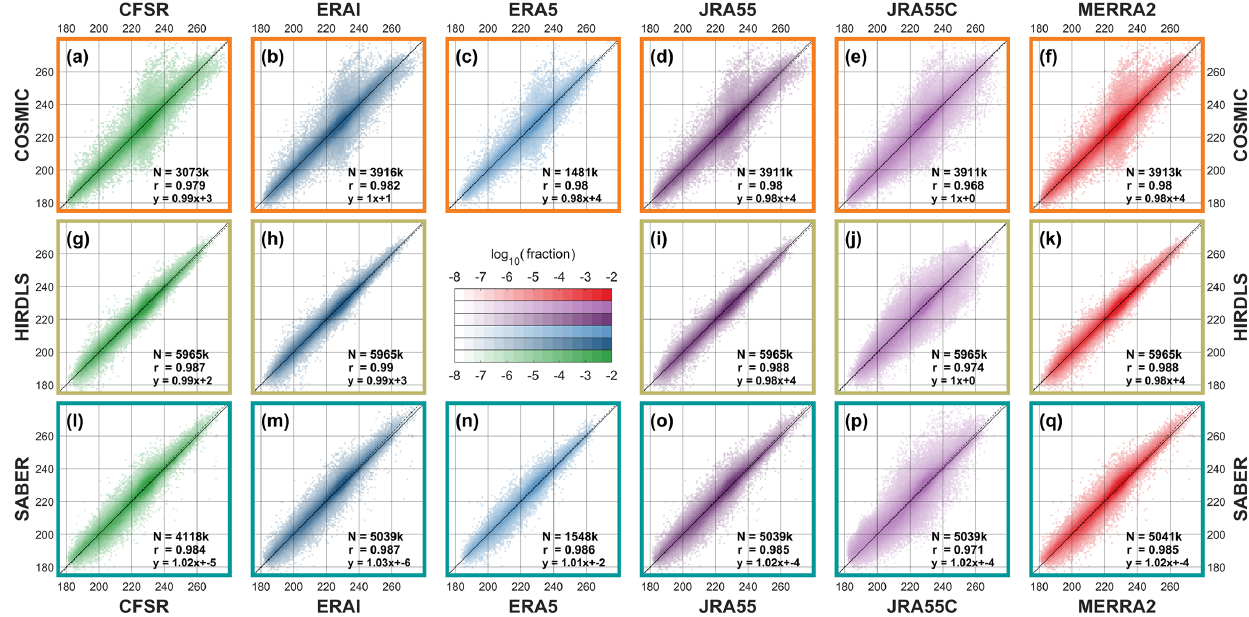
Figure 5. Scatter-density plots comparing each instrument (rows) to synthetic measurements generated from each reanalysis (columns) at 30km in altitude. For each panel, pixels indicate the proportion of all samples with the (vertical axis) observed and (horizontal axis) simulated temperature. The solid black line indicates a 1 : 1 correspondence among the datasets, and the dashed line is a linear fit to the results – note that the dashed line very closely overlies the solid line. Text annotations show the number of contributing sample pairs ( N , in thousands of samples), the Pearson linear correlation coefficient of the two datasets ( r ), and the equation of the linear fit line (in the form y = mx + c , where y is the instrument, x the sampled model, m the gradient and c the y -axis intercept.)